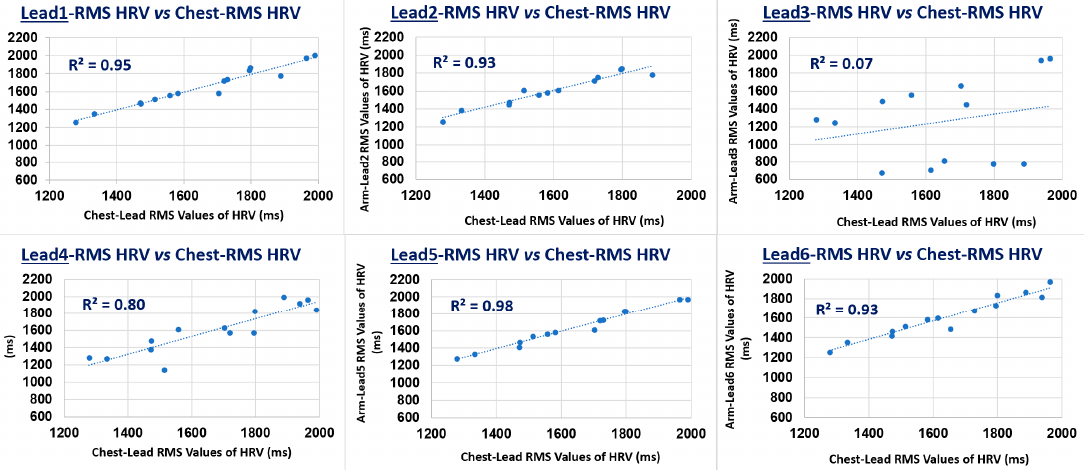
Figure 9. Scatter plot of 18 data pair/case points and associated trendline coefficient of determination (R2) of HRV RMS metric measured values (ms) on arm leads (1–6) versus measured values (ms) on the Chest Lead-I.